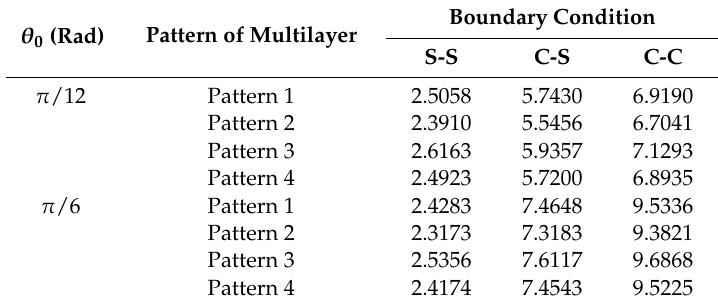
Table 5. Variation of the first natural frequency for a FG curved nanobeam with di ff erent patterns and boundary conditions, and two opening angles.